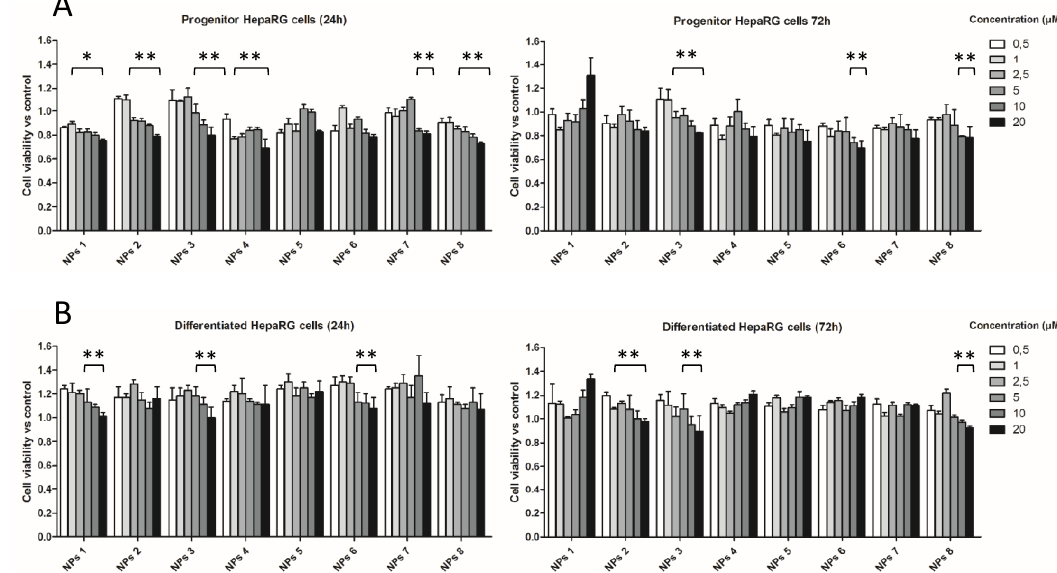
Figure 1. MTT assays (viability assay) in progenitor ( A ) and hepatocyte-like HepaRG cells (differentiated cells, B ) incubated with PMLABe-based nanoparticles at 24 h (24 h) and 72 h (72 h). Statistical analyses: * p < 0.05; ** p < 0.01 versus non treated cells, three independent experiments.